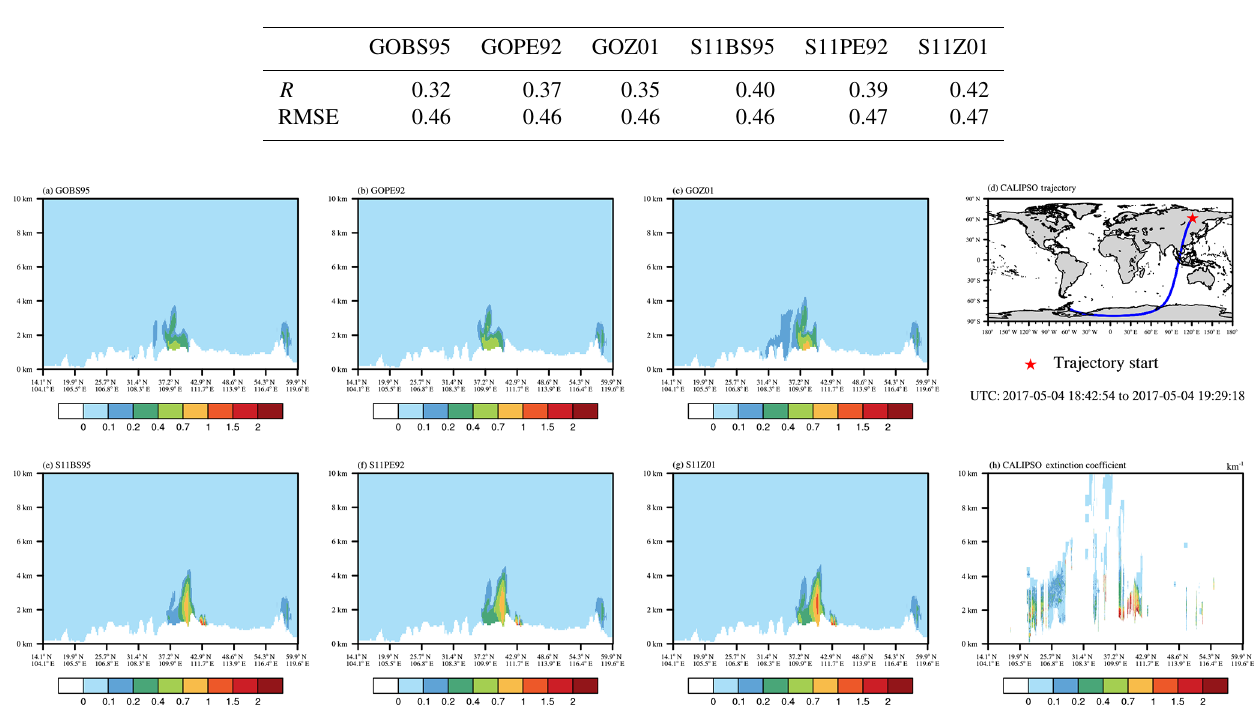
Figure 10. Simulated and observed aerosol extinction profiles at 532nm at 18:00UTC on 4 May. Panel (d) shows the CALIPSO trajectory. Panel (h) shows the CALIPSO observed extinction coefficient. Panels (a) – (g) show the WRF-Chem-simulated extinction coefficient from six